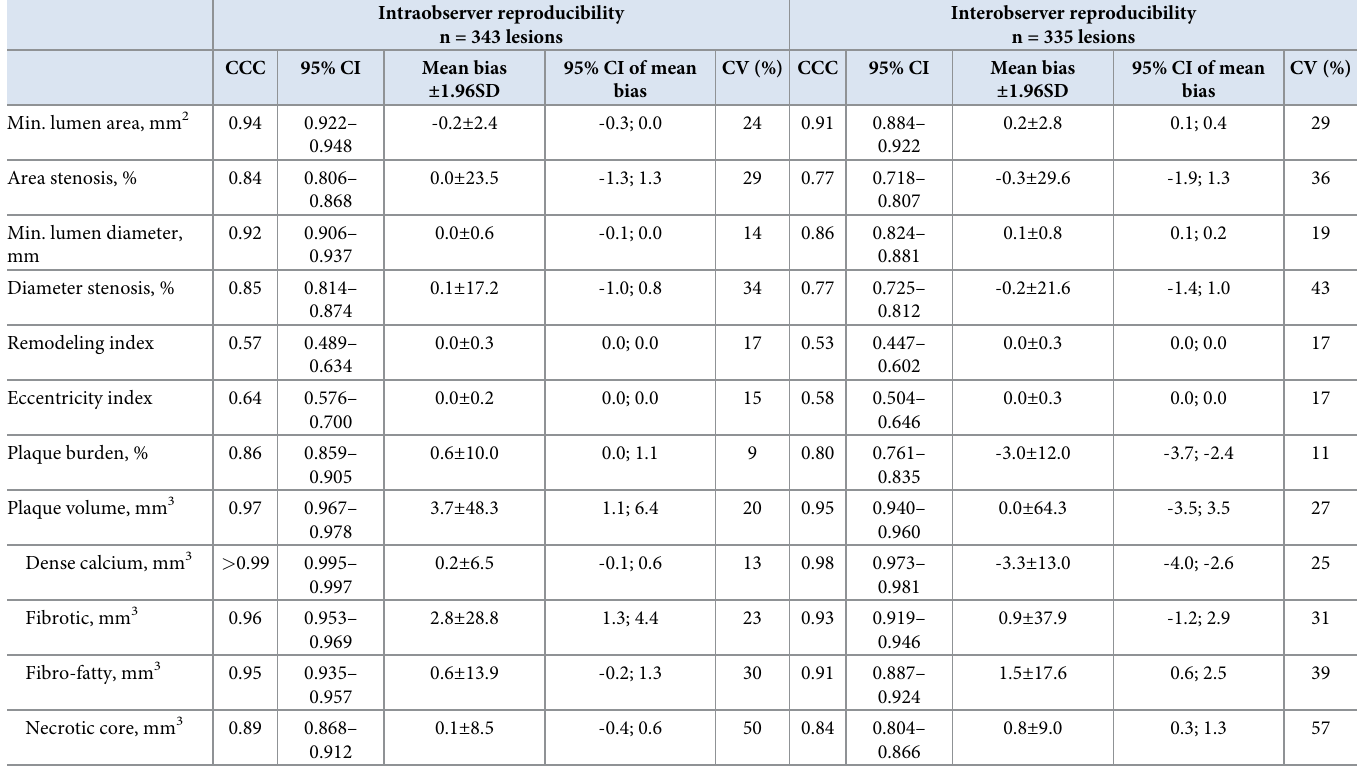
Table 3. Intraobserver and interobserver reproducibility estimates on a lesion